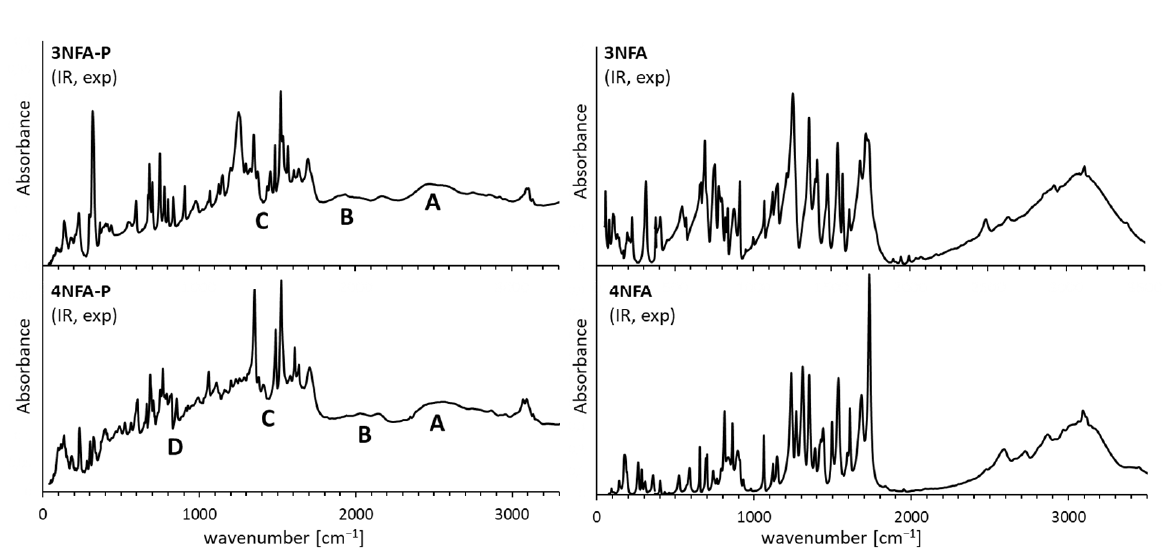
Figure A1. Experimental IR spectra of 3NFA-P , 4NFA-P complexes ( left panels) and 3NFA , 4-NFA ( right panels) compounds.